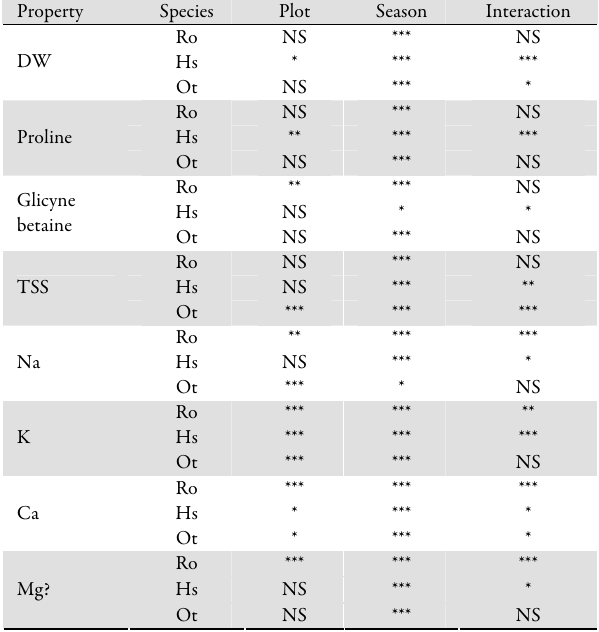
Table 2. Significant effect of spatial (plot) and seasonal variations of plant osmolytes and cations for the three species present in the three plots at ANOVA. NS: not significant. Species abbreviations as in Fig. 1